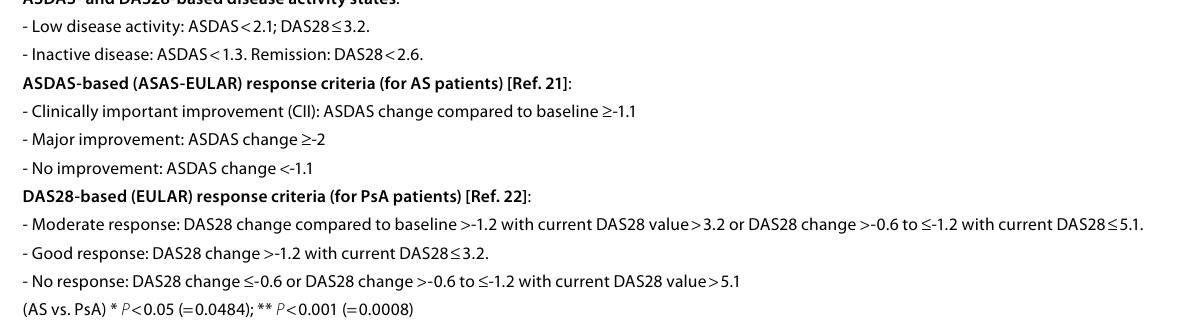
All patients AS patients PsA patients